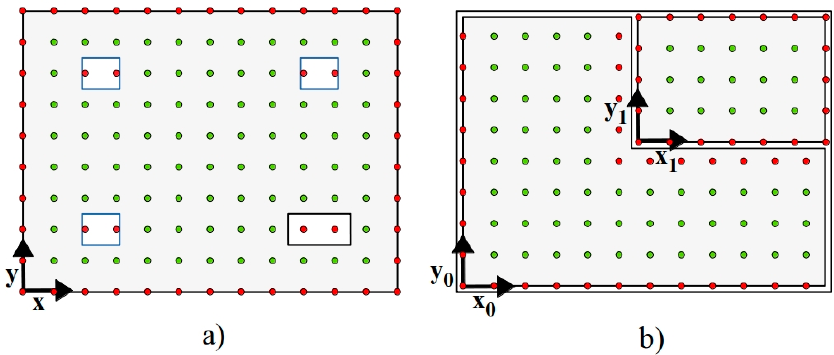
Figure 4. Schema of discretization process when using a grid-based structure ( a ) in case of the existence of one floor space including a hole and three columns (blue lines) ( b ) in case of the existence of rooms. Final candidate positions are in green, while discarded candidate positions are in red. Local coordinate systems are represented.